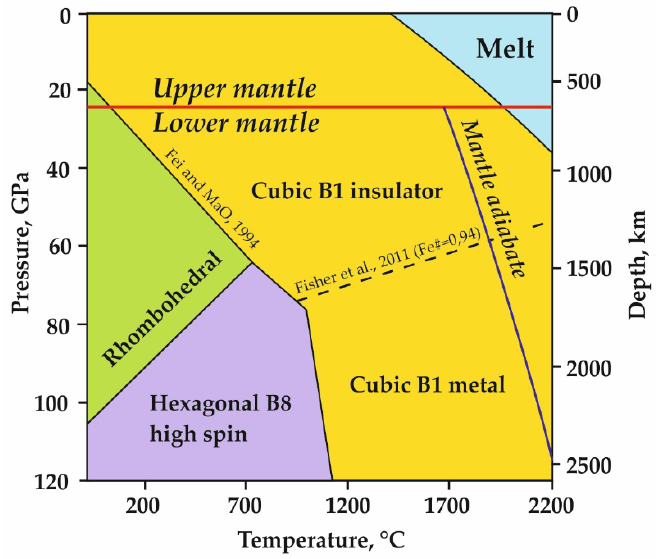
Figure 1. Phase diagram for wüstite at high pressures and temperatures, after [18]. Data from References [7,21–28]. Mantle adiabate after [29].